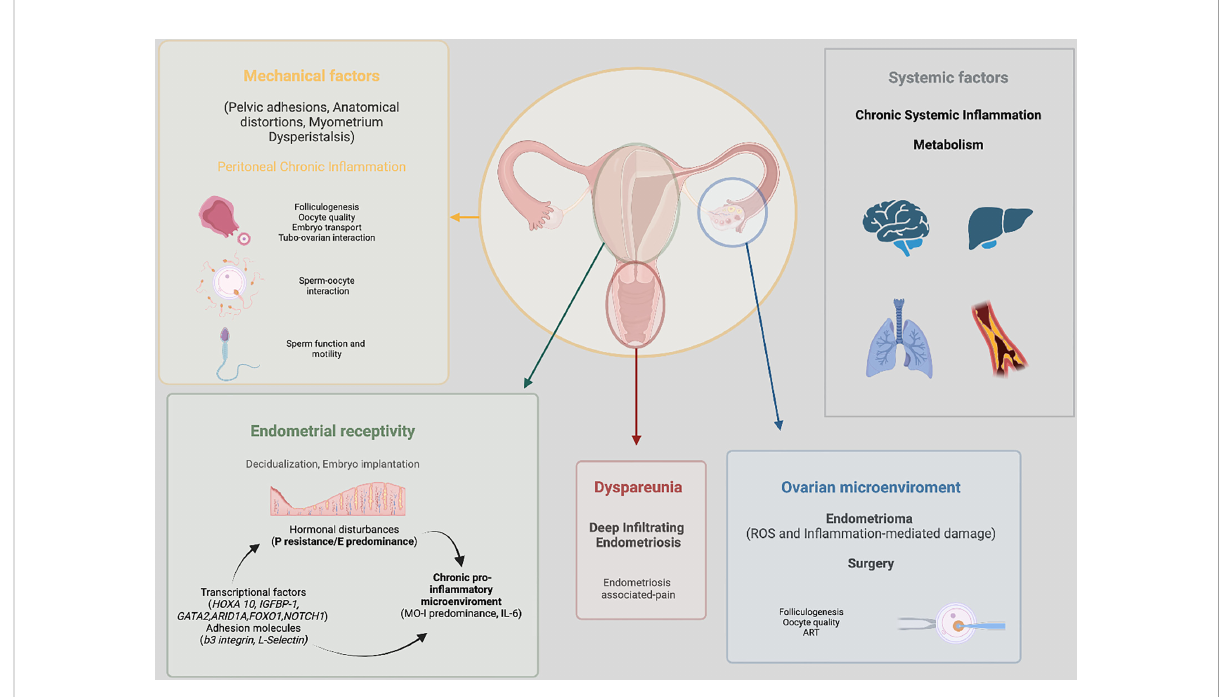
FIGURE 2 Summary of the main pathophysiological processes implicated in endometriosis associated